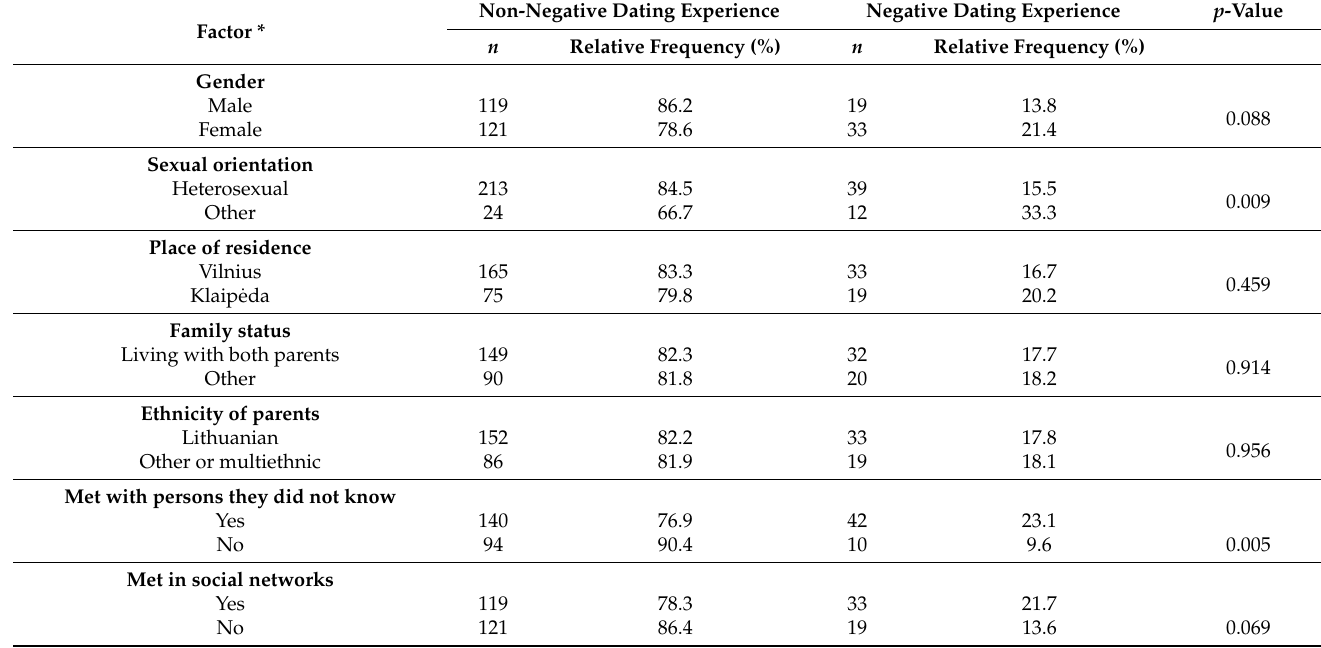
Table 2. Distributions of the respondents regarding dating experience (presence of harassment) and socio-demographic